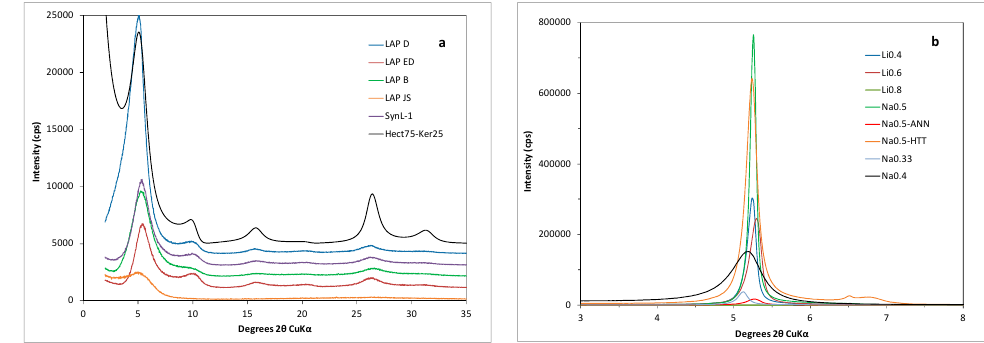
Figure 2. XRD traces of the EG-solvated synthetic Mg-Li smectites. ( a ) Samples from the first and second sample sets, the Hect75-Ker25 is the fitting trace of R0 mixed layer smectite-kerolite obtained by Newmod code. ( b ) Samples from the third and fourth sample sets.